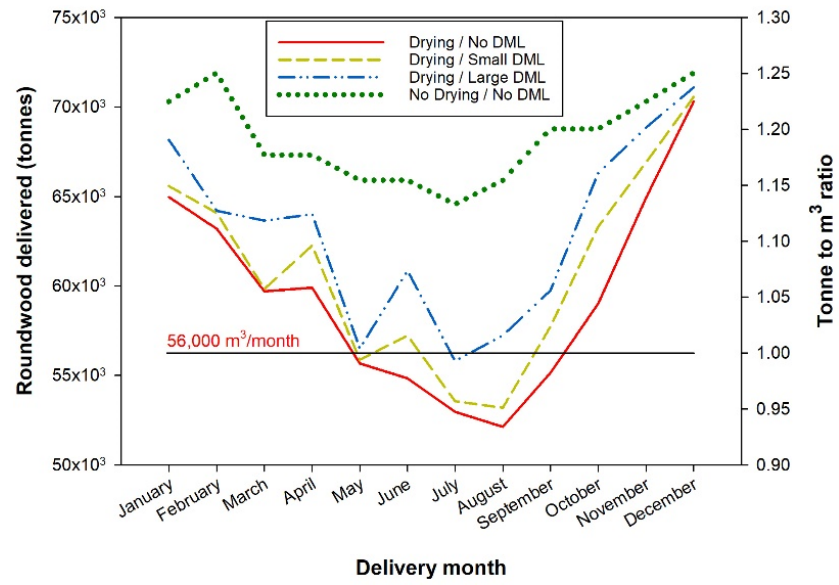
Figure 7. Tonnes of roundwood delivered to the pulp mill and tonnes-to-m 3 ratios by scenario and month. The horizontal solid black line represents the demand for roundwood that must be satisfied each month.